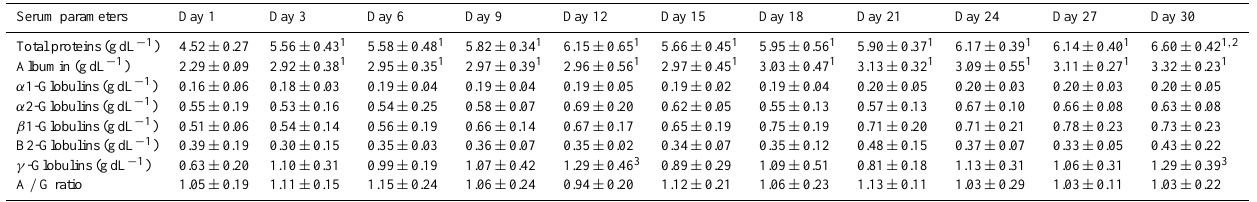
Table 1. Mean values ± SD (standard deviations) of serum total proteins, albumin, globulins and A / G Ratio levels in nine growing foals during the first month of